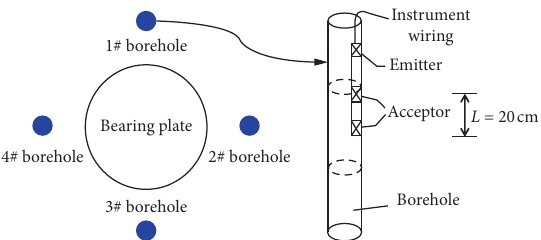
Figure 6: Layout of acoustic tests of borehole rock